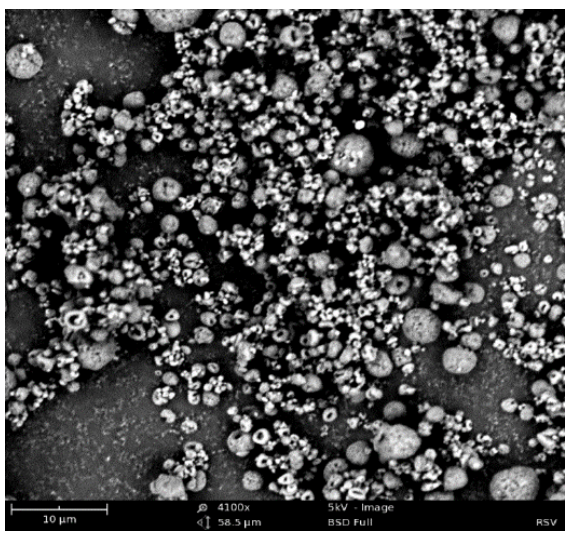
Figure 2. SEM images of RSV-F VLP-loaded microparticles. SEM images were captured using Phenom Desktop SEM ® by placing the microparticles on a conductive carbon tape and observed at 4100X, 5 kV. Microparticles exhibited an irregular shape with a particle size range of 1 to 4 µm.